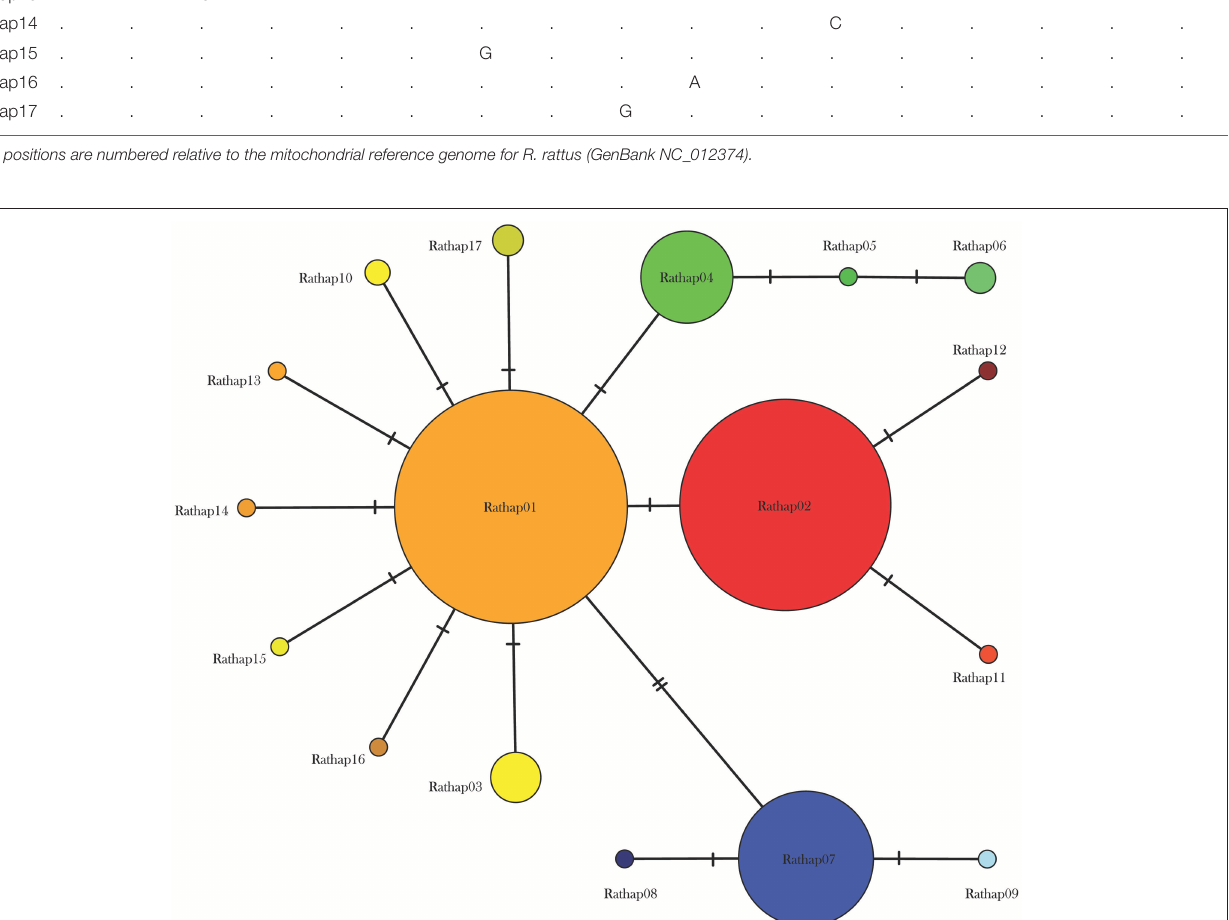
mutation in VKorc1, which is associated with anti-coagulant resistance, also corresponds with the distribution of haplotype Rathap02 (Cowan et al.,